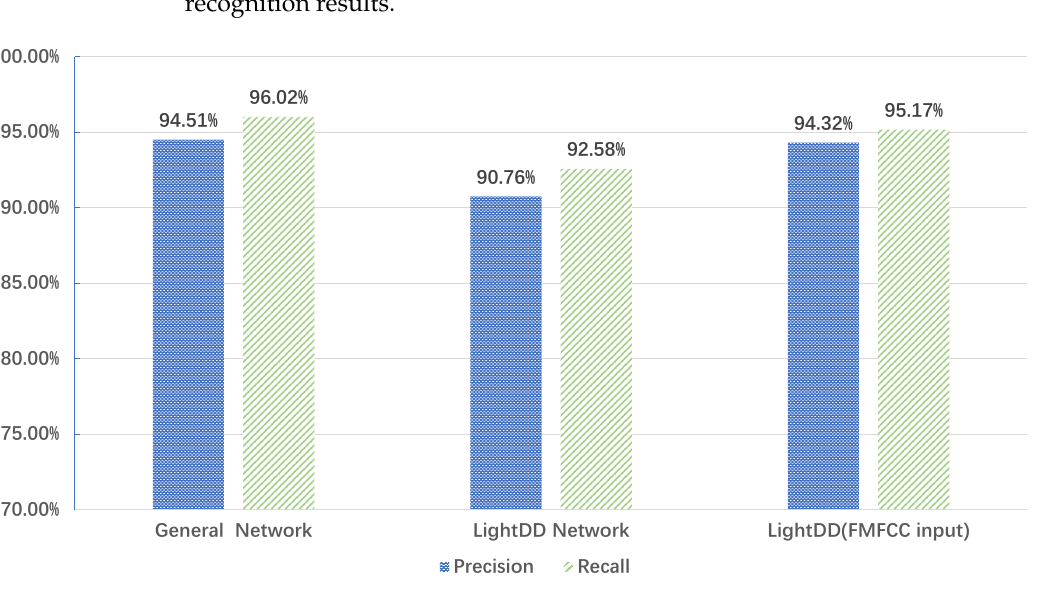
Figure 9. System accuracy in three